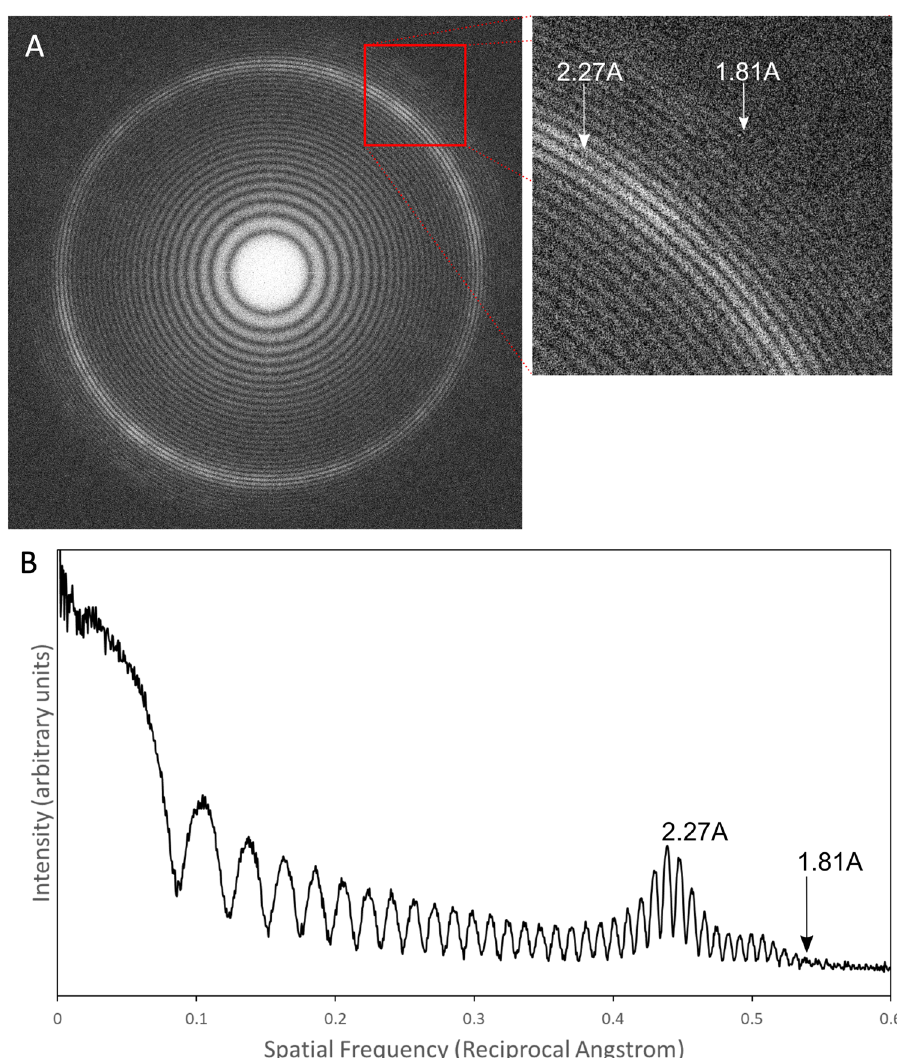
Figure 2. Performance of the cryo-HVEM (JEOL JEM-1000EES) equipped with a Gatan K2 Summit direct electron detector using a Pt-Ir standard sample. ( A ) Power spectrum showing clear Thon rings. ( B ) A focussed view of the Thon rings. ( C ) 1D plot of the power spectrum calculated with the "Radial Profile Extended" plugin of Fiji 75